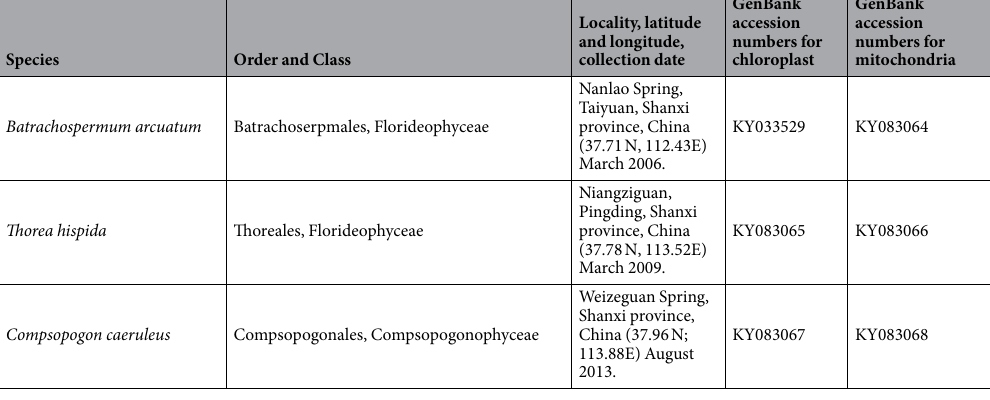
Table 1. Specimen information used in this